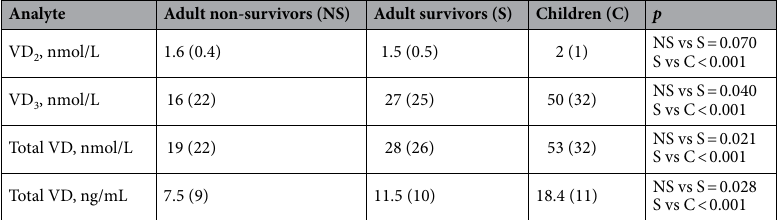
Table 2. Comparative VD levels between adult non-survivors, adult survivors and children. Data are expressed as median (interquartile range, IQR).